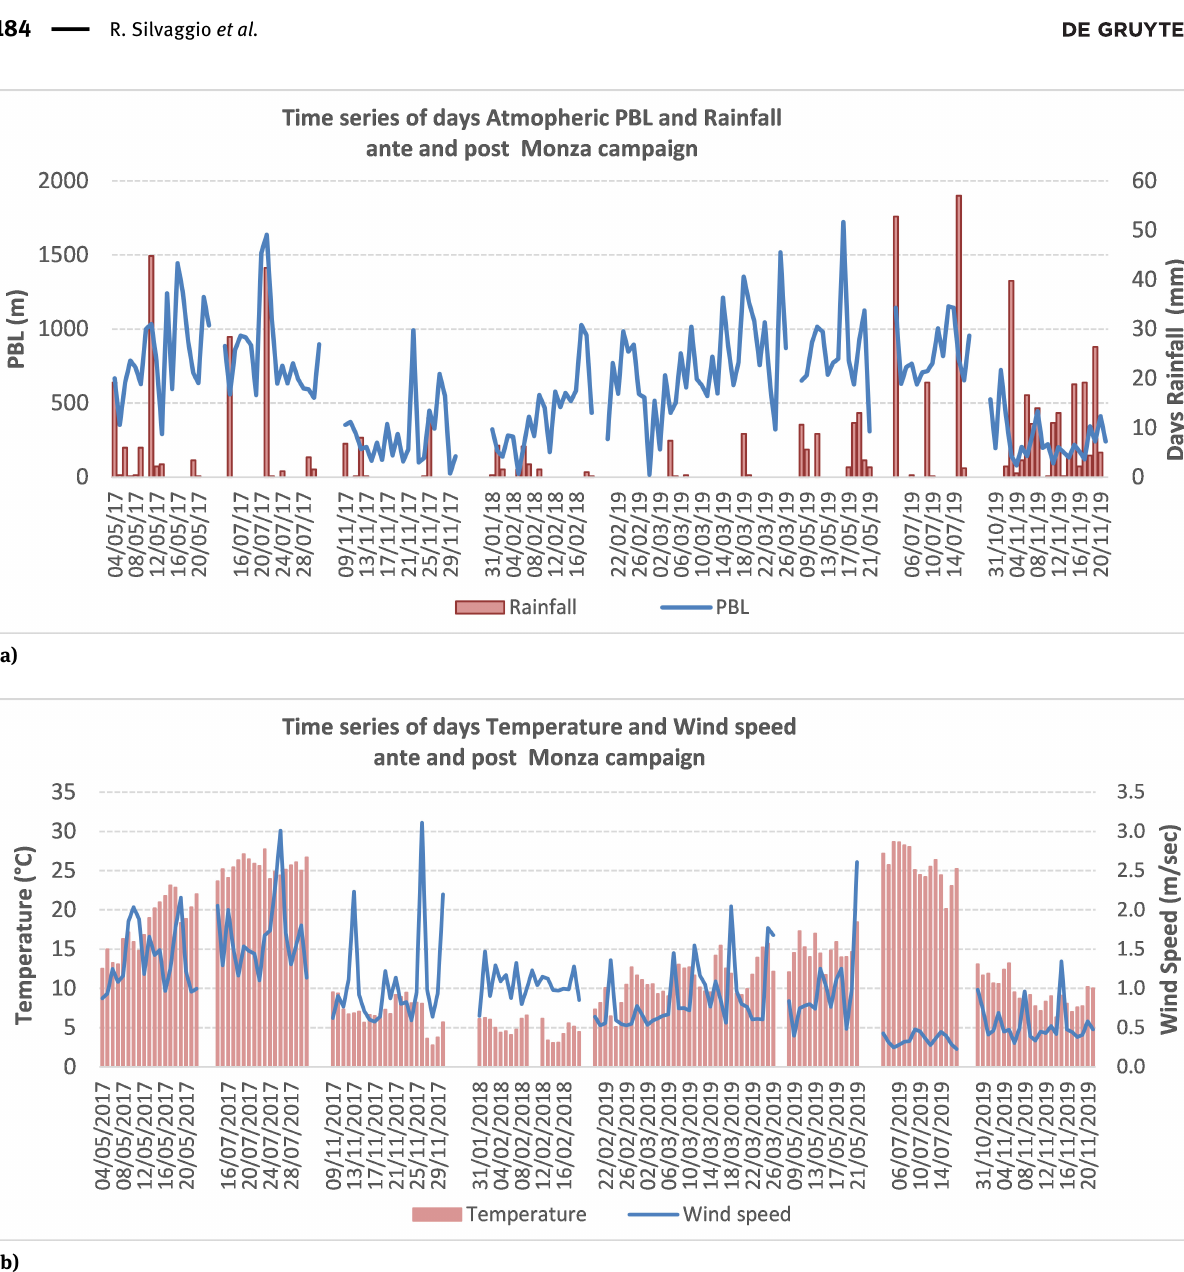
away within the Milan agglomerate, very consistent and contained in a narrow range of values (Figure